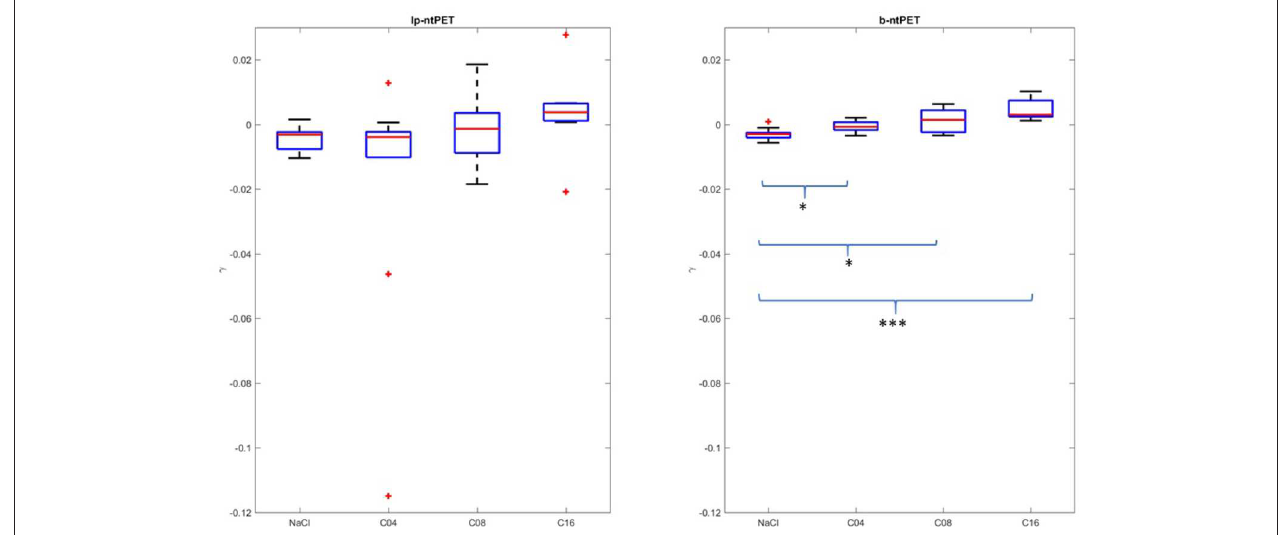
FIGURE 11 | Magnitudes of the displacement ( γ ) estimated by both methods in the hippocampal region. The conditions NaCl, C04, C08, and C16 correspond to saline injection, and injections of 0.04, 0.08, and 0.16 mg/kg of 5-HT 1A agonist, respectively. Whiskers represent 1.5 times the IQR. (Two-sample t -test: * p < 0.05; *** p <